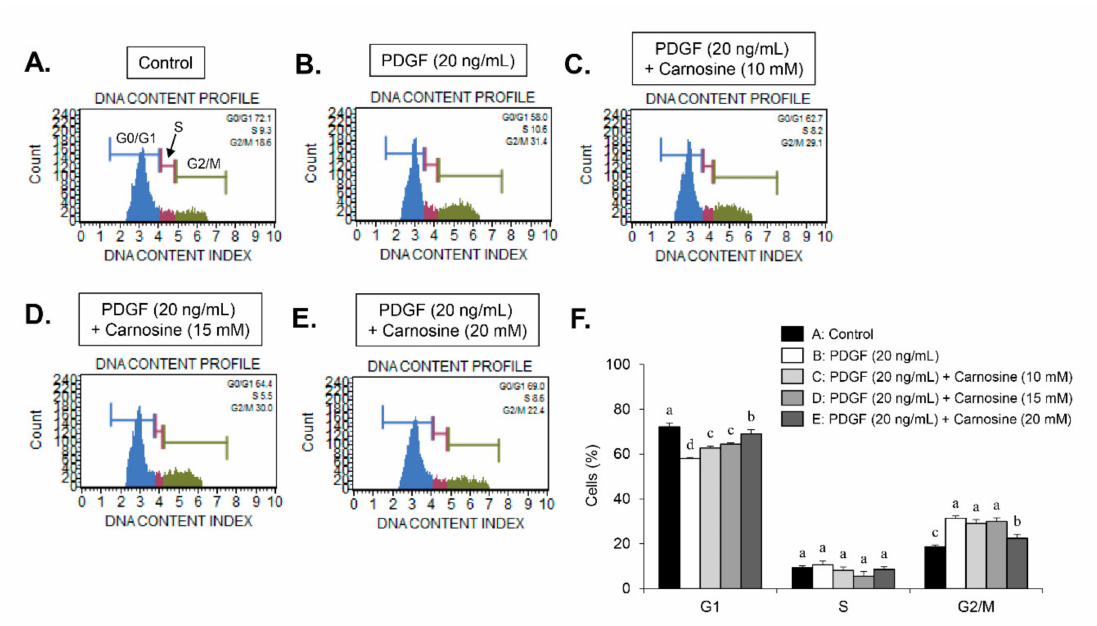
Figure 2. Carnosine-induced G1-phase cell cycle arrest in PDGF-treated VSMCs. VSMCs were pre-cultured with various concentrations of carnosine for 45 min and then incubated with PDGF (20 ng / mL) for 24 h. FACS histograms are shown for ( A ) control (Con), ( B ) PDGF alone, ( C ) 10 mM carnosine with PDGF, ( D ) 15 mM carnosine with PDGF, ( E ) 20 mM carnosine with PDGF, and ( F ) cell cycle distribution is expressed as the percentages of cells at the G1-, S-, and G2 / M-phases. Values are expressed as mean ± SD values of three independent experiments. The di ff erent letters indicate significant di ff erences between the groups ( p <